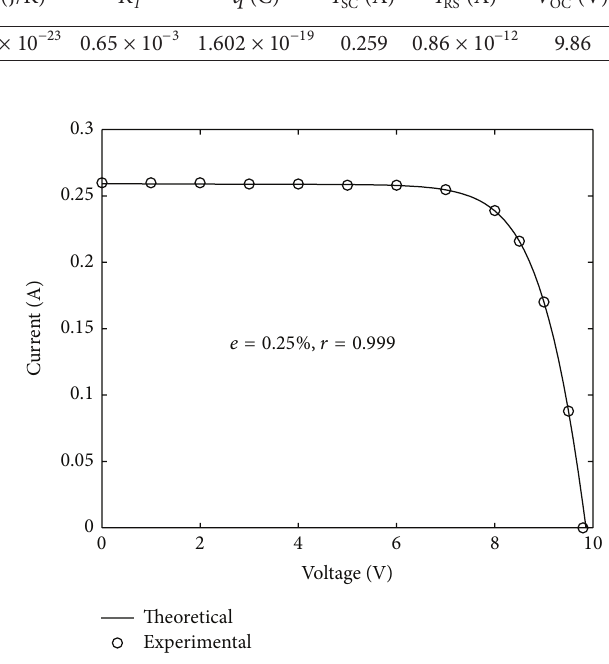
Figure 4: Current-voltage characteristics of the designed solar PV module under 1 Sun, AM1.5 at 298.14